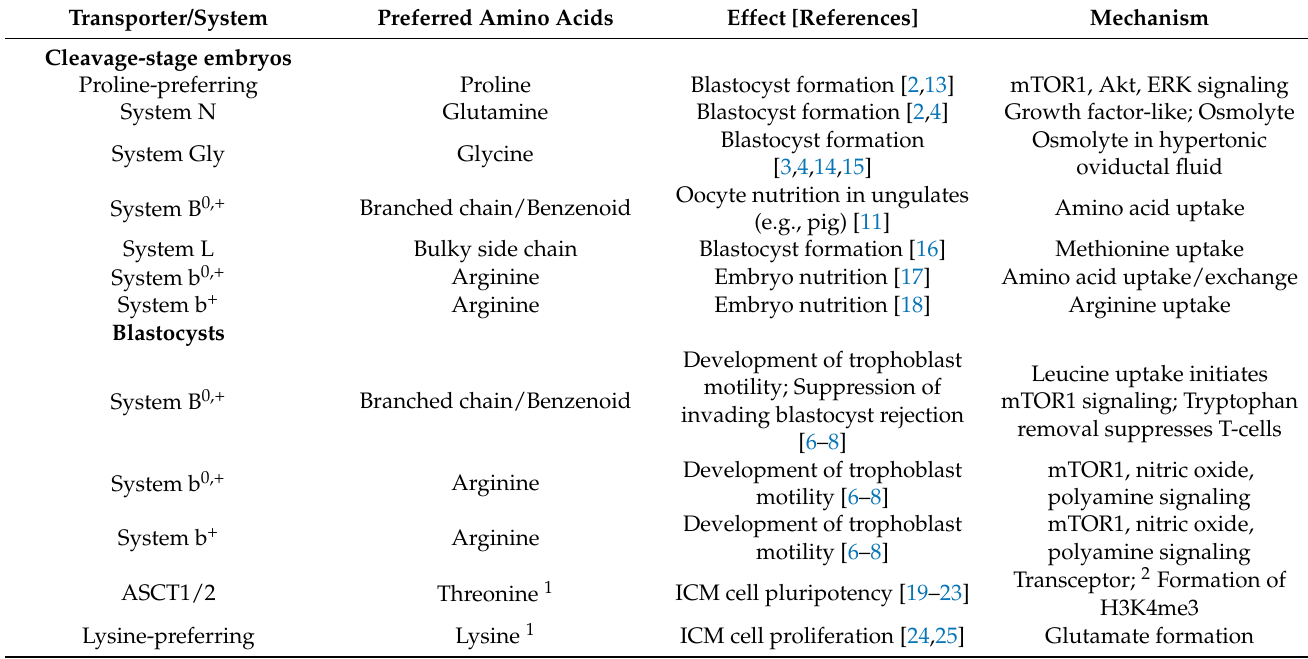
Table 1. Effect of amino acid transporters/transport systems on early embryo development. Transporter/System Preferred Amino